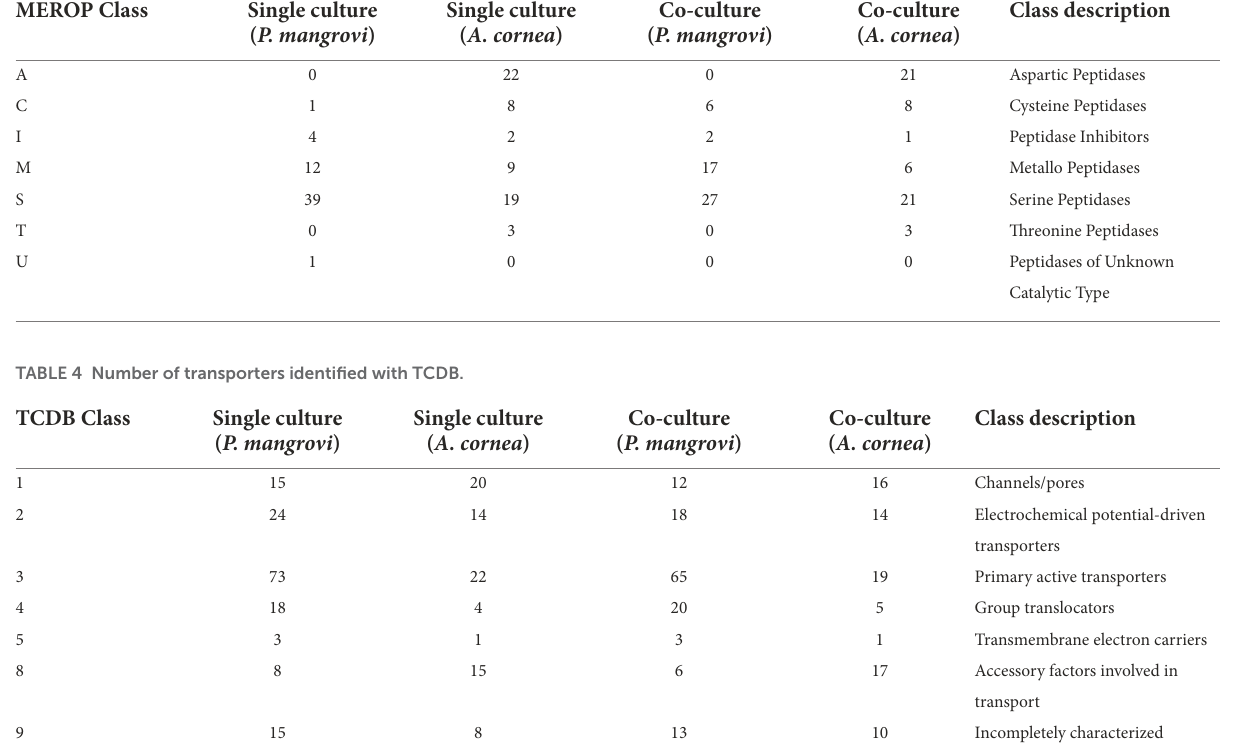
TABLE 3 Number of peptidases identified with MEROPS 12.1 database. MEROP Class